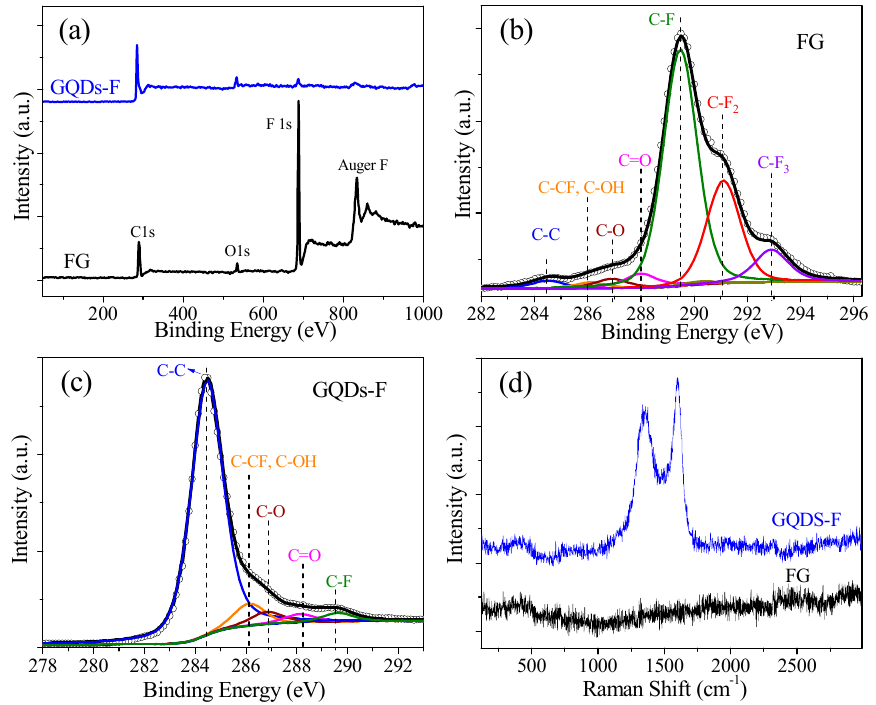
Figure 2. ( a ) The survey X-ray photoelectron spectra (XPS) spectra of FG and GQDs-F samples; ( b ) The C 1s XPS of FG, which were fine-scanned and deconvoluted into several components; ( c ) The C 1s XPS of GQDs-F, which were fine-scanned and deconvoluted into several components; ( d ) The Raman spectra of FG and GQDs-F. Table 1. The locations and contents of chemical groups in the samples determined from the integral intensities of C 1s XPS peak.